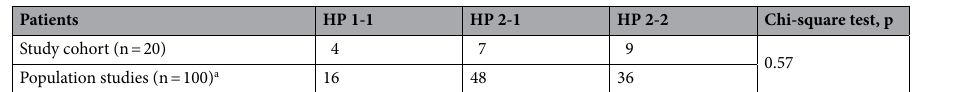
Table 2. Distribution of Haptoglobin (HP) isotypes in the study cohort was compared by Chi-square to the distribution of HP isotypes from population prevalence studies. a The distribution of HP isotypes for the population cohort were obtained from references 16 and 17